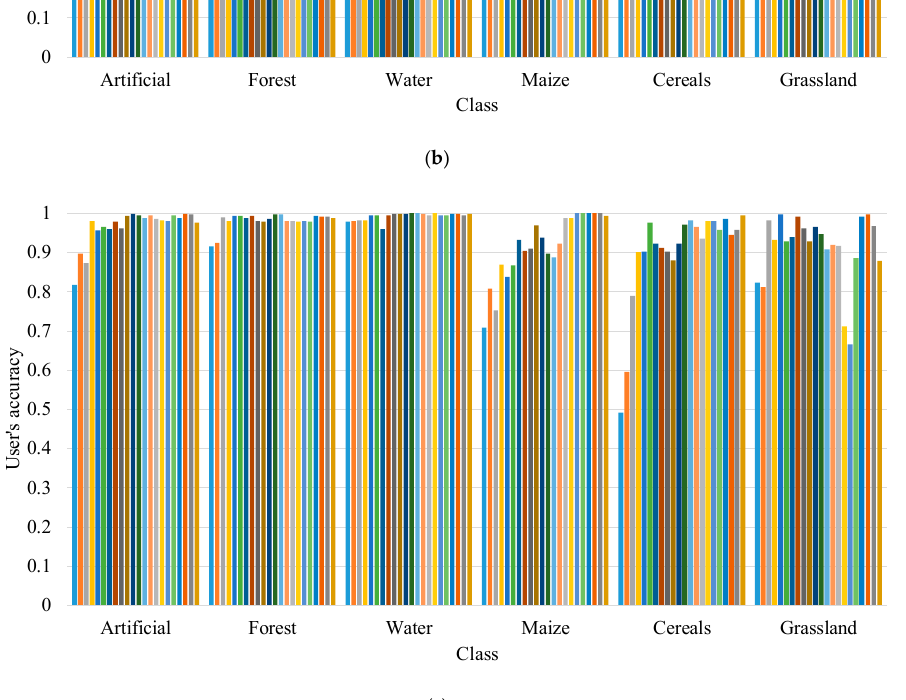
Figure 7. The user’s accuracy (UA) of each class with an increasing number of images used at different segmentation scales for Study Area 2. ( a ) Scale 50, ( b ) scale 100, and ( c ) scale 150. The colored bars from left to right represent the number of images from 1 to 22.